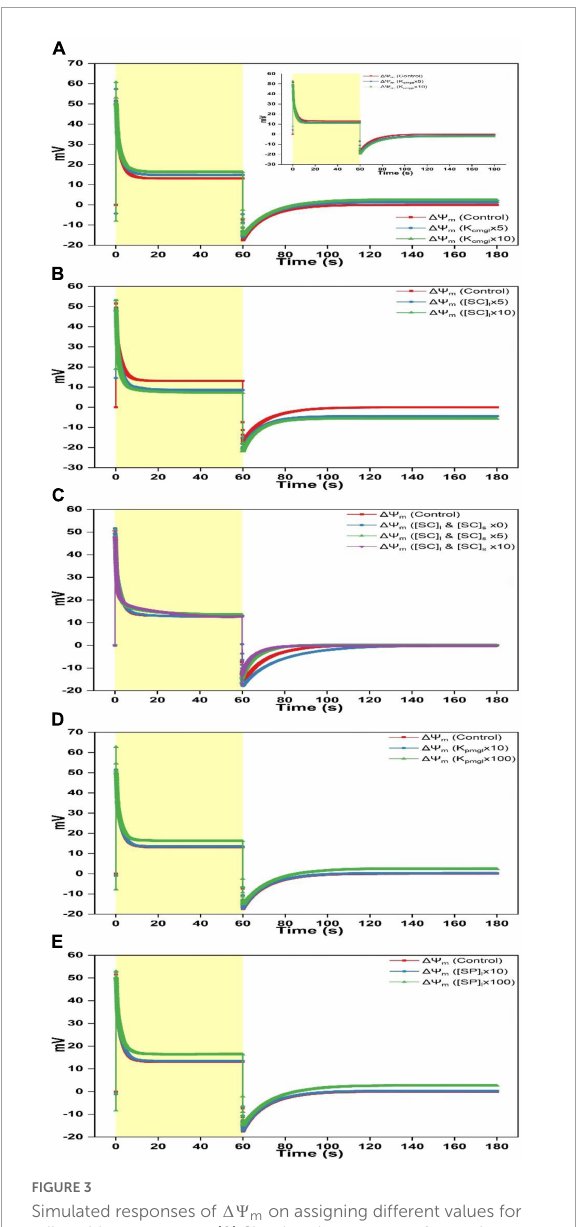
FIGURE3 Simulated responses of (cid:49)(cid:57) m on assigning different values for adjustable parameters. (A) Simulated responses of (cid:49)(cid:57) m by adjusting K cmgl 1-, 5-, and 10-fold of the controlled value. The insert illustrates simulated responses of (cid:49)(cid:57) m by adjusting K cmgs 1-, 5-, and 10-fold of the controlled value. (B) Simulated responses of (cid:49)(cid:57) m by adjusting [SC] l 1-, 5-, and 10-fold of the controlled value. (C) Simulated responses of (cid:49)(cid:57) m by adjusting [SC] l and [SC] s 0-, 1-, 5-, and 10-fold of the controlled value. (D) Simulated responses of (cid:49)(cid:57) m by adjusting K pmgl 1-, 10-, and 100-fold of the controlled value. (E) Simulated responses of (cid:49)(cid:57) m by adjusting [SP] l 1-, 10-, and 100-fold of the controlled value.